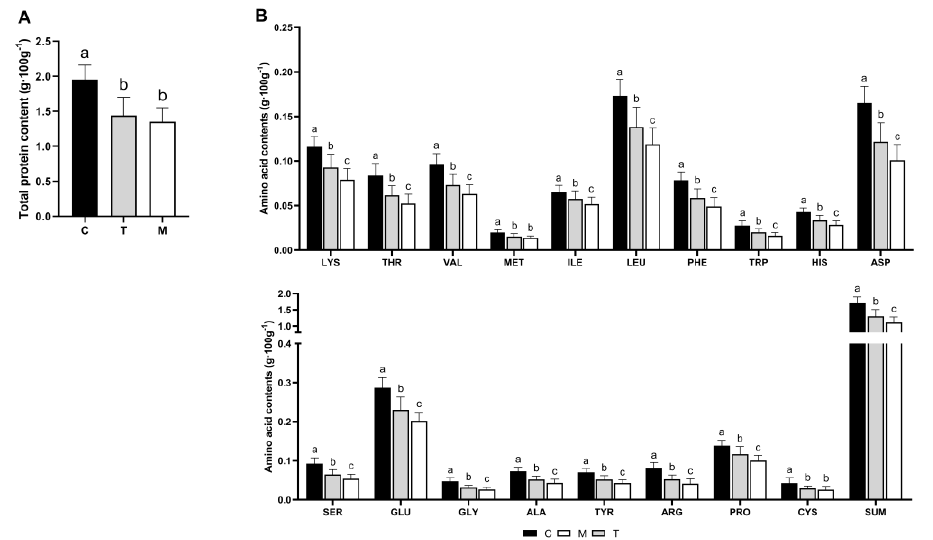
Figure 1. Comparison of total protein contents and amino acid contents in different lactation periods. Different letters represent significant differences in total protein contents in different lactation periods ( p < 0.05); C, colostrum (3–6 days); T, transitional milk (7–14 days); M, mature milk (15–29 days) ( A ) total protein contents. ( B ) total amino acid contents.